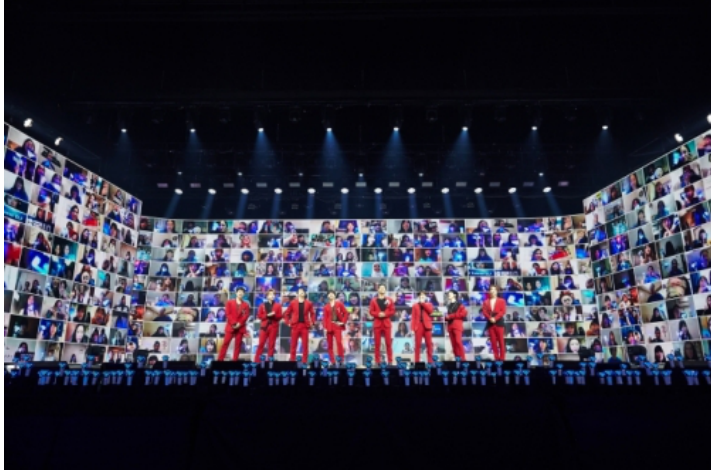
Figure 1. ( a ) Realspace ( b ) portal identification algorithm and portal scores ( c ) extended lecturer space ( d ) the use of the video see-through headset.